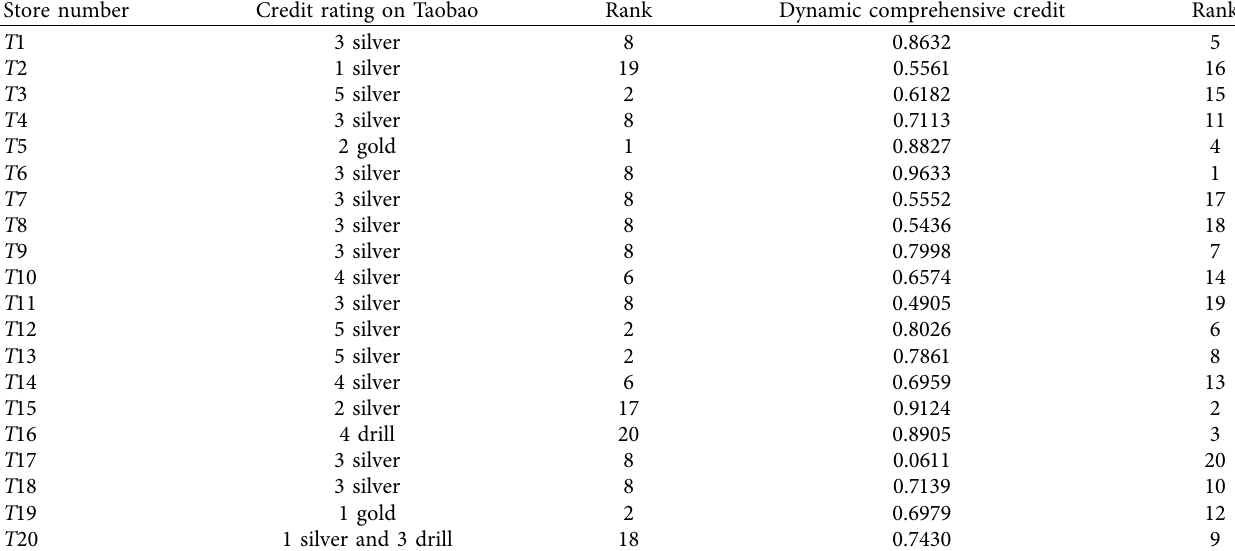
Table 4: Credit comparison table.